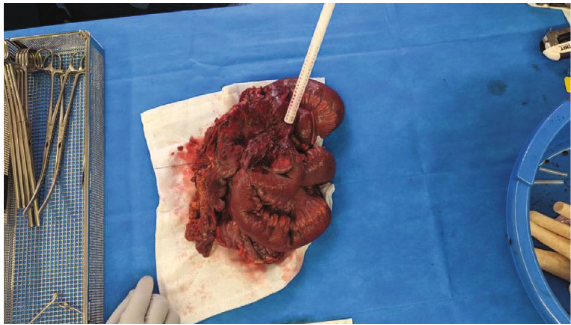
Figure 3: Intra-op specimen revealing site of perforation on evacuating faecaloma